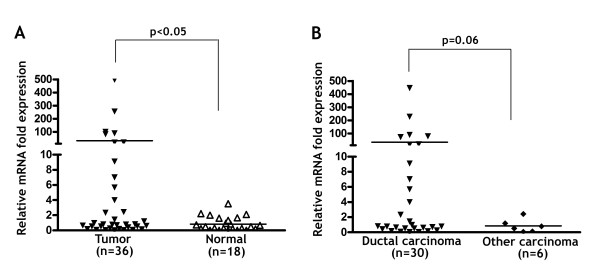
t-DARPP is overexpressed in primary breast tumors. A, normal adjacent (n = 18) and tumor (n = 36) breast tissue samples were analyzed by quantitative real time RT-PCR for t-DARPP mRNA expression. RT-PCR results were normalized with the internal control genes β-actin and HPRT1. The results were plotted as a ratio of normalized t-DARPP mRNA expression by the average of normalized t-DARPP mRNA expression of normal samples. Overexpression of t-DARPP was detected in 36% of breast tumors relative to normal tissue samples (p < 0.05). B, the overexpression of t-DARPP was overwhelmingly observed in ductal carcinomas (p = 0.06), including invasive ductal carcinomas and intraductal carcinomas, as opposed to other types of breast cancers. The other types of breast cancers include 1 invasive lobular carcinoma, 1 mucinous carcinoma, 1 apocrine carcinoma and 3 undifferentiated carcinomas. Horizontal bars indicate mean values. Mann Whitney test was used for statistical analysis in A and B.